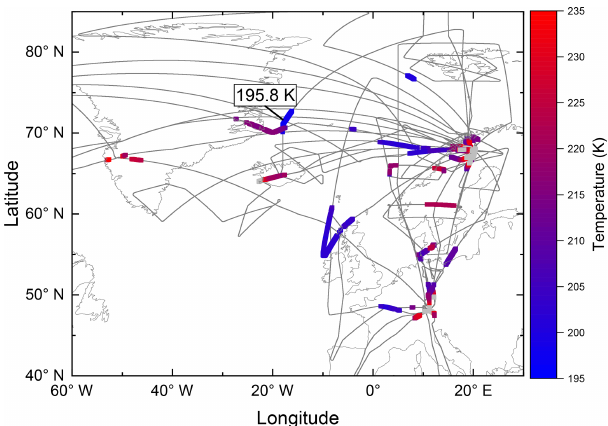
Figure 2. Map of the North Atlantic showing the flight tracks of the POLSTRACC campaign. Coloured sections denote the IWC mea- surements from the WARAN instrument. The colour coding indi- cates the temperature during these sections: red is warmer than blue, and grey colours are above 235K.